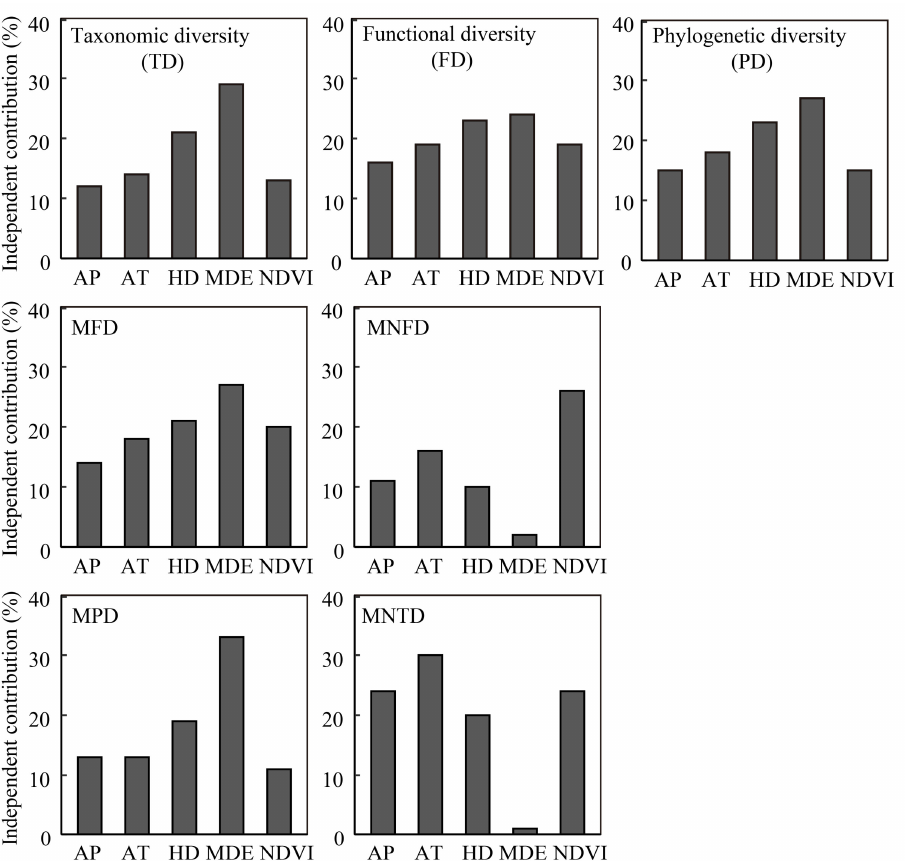
Figure 6. The proportion of the independent contribution of each predictor variable to model- explained diversity variances derived by hierarchical partitioning. Abbreviations: TD, taxonomic diversity; FD, functional diversity; PD, phylogenetic diversity; MFD, mean pairwise functional distance; MPD, mean pairwise phylogenetic distance; MNFD, mean nearest functional taxon distance; MNTD (P), mean nearest phylogenetic taxon distance; AP, annual precipitation; AT, mean annual temperature; HD, human disturbance; MDE, the mid-domain effect; NDVI, normalized difference vegetation